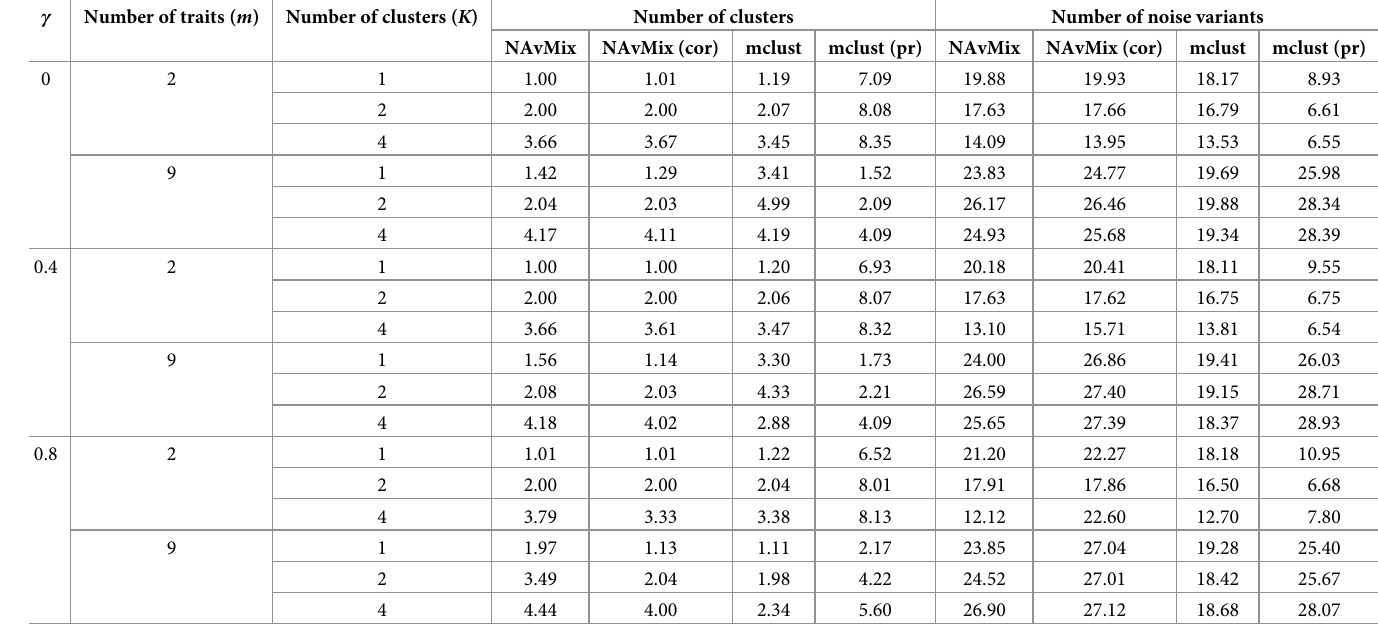
Table 1. Mean number of clusters estimated and mean number of observations allocated to the noise cluster for each simulated scenario using NAvMix, NAvMix incorporating trait correlation estimates (cor), mclust, and mclust using proportional associations (pr). The true number of variants in the noise cluster is